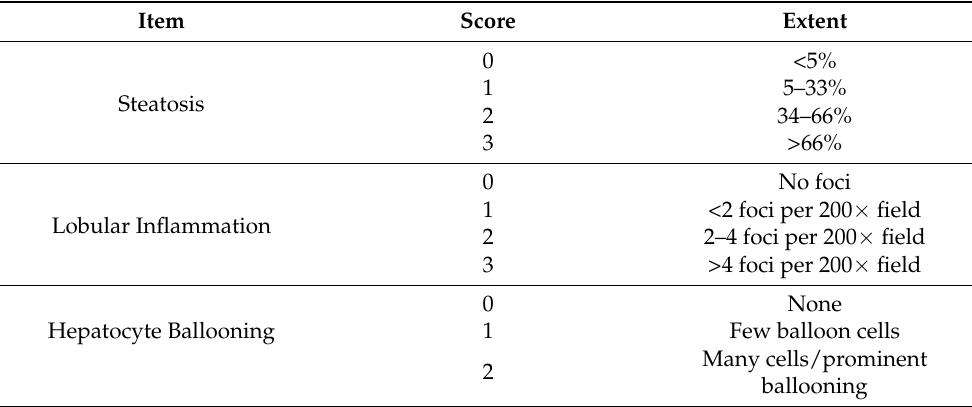
Table 1. NAFLD activity score (NAS)